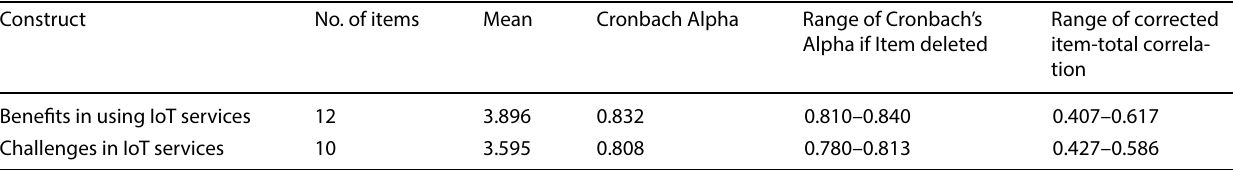
Table 2 Summary of the findings of reliability test Construct